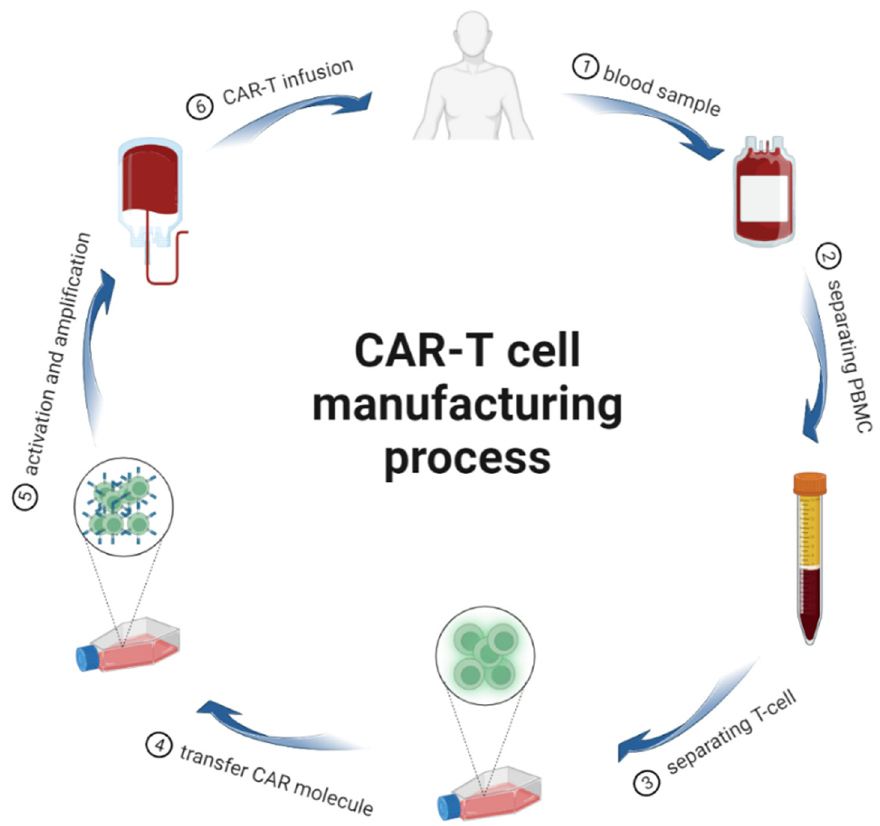
Figure 1. The CAR-T cell manufacturing process.